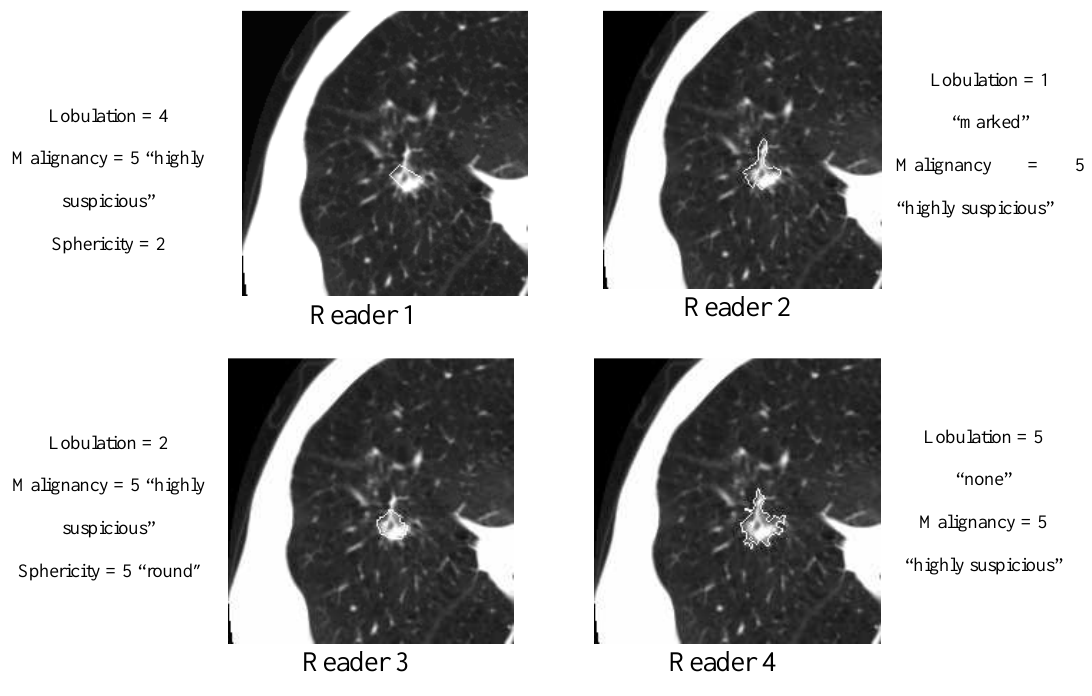
Figure 1. An example of four different delineations of a nodule on a slice marked by four different radiologists.